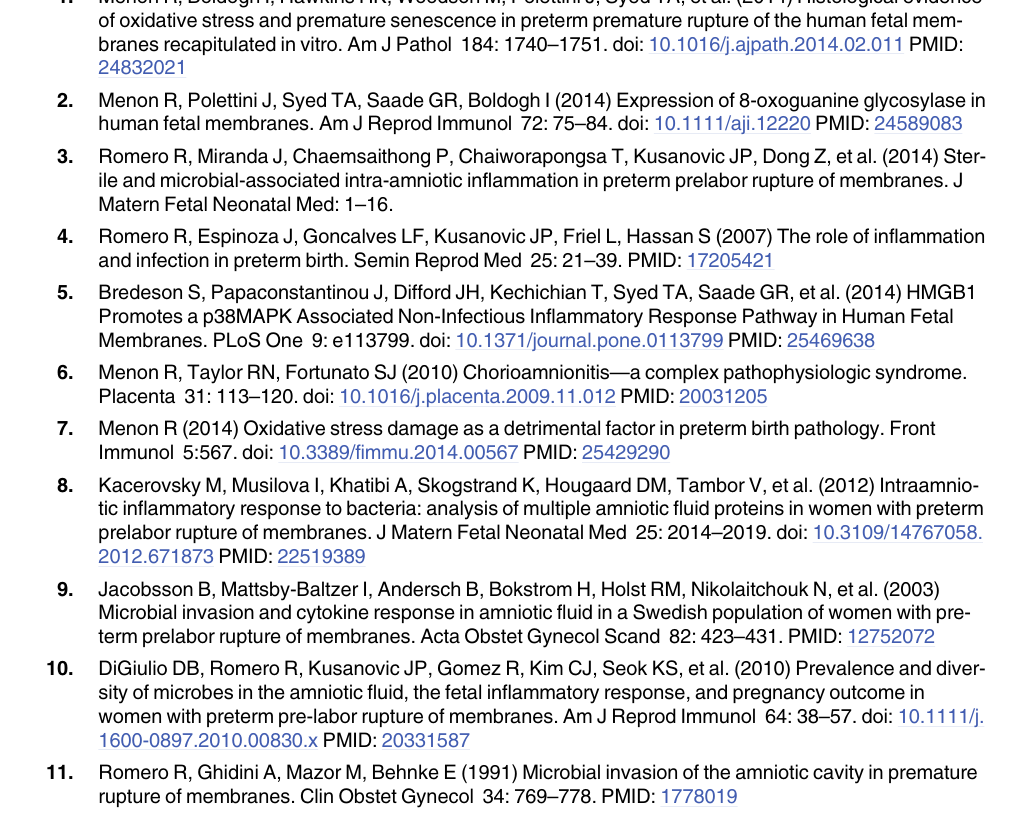
S1 Table. Amniotic fluid IL-6 levels, the presence of histological chorioamnionitis, funisi- tis, and the presence of neutrophil infiltration (grades 1 – 4) in the chorion-decidua, chori- onic plate, umbilical cord, and amnion in preterm prelabor rupture of membrane pregnancies that are complicated with the presence or absence of microbial-associated intraamniotic inflammation, sterile intraamniotic inflammation and microbial invasion of the amniotic cavity